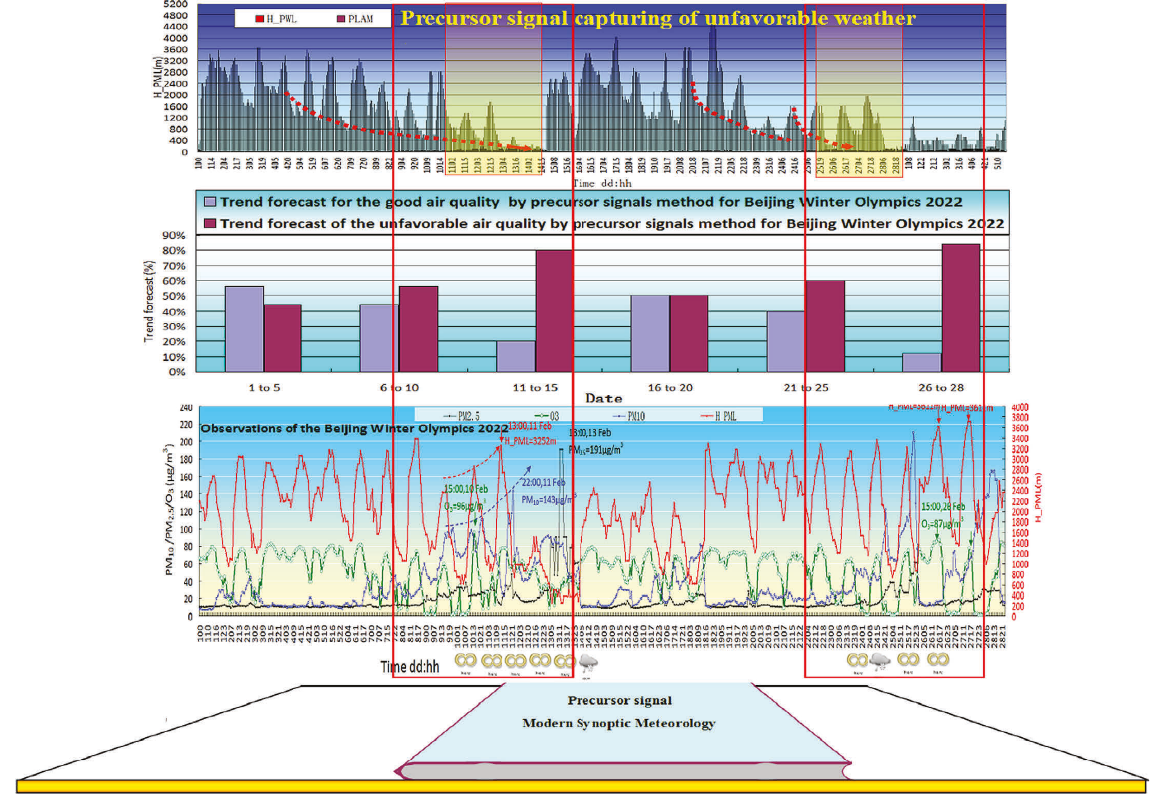
Figure 9: Comprehensive physical diagram of the precursor signal capturing for ultra-early high-resolution air quality weather prediction